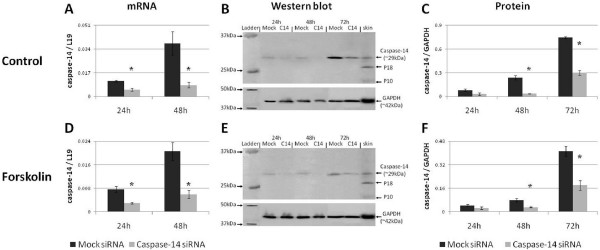
Suppression of Caspase-14. Validation of the success of RNAi in suppressing caspase-14 in (A-C) control BeWo cells and (D-F) during differentiation. * = P < 0.05 versus controls at the same time point.